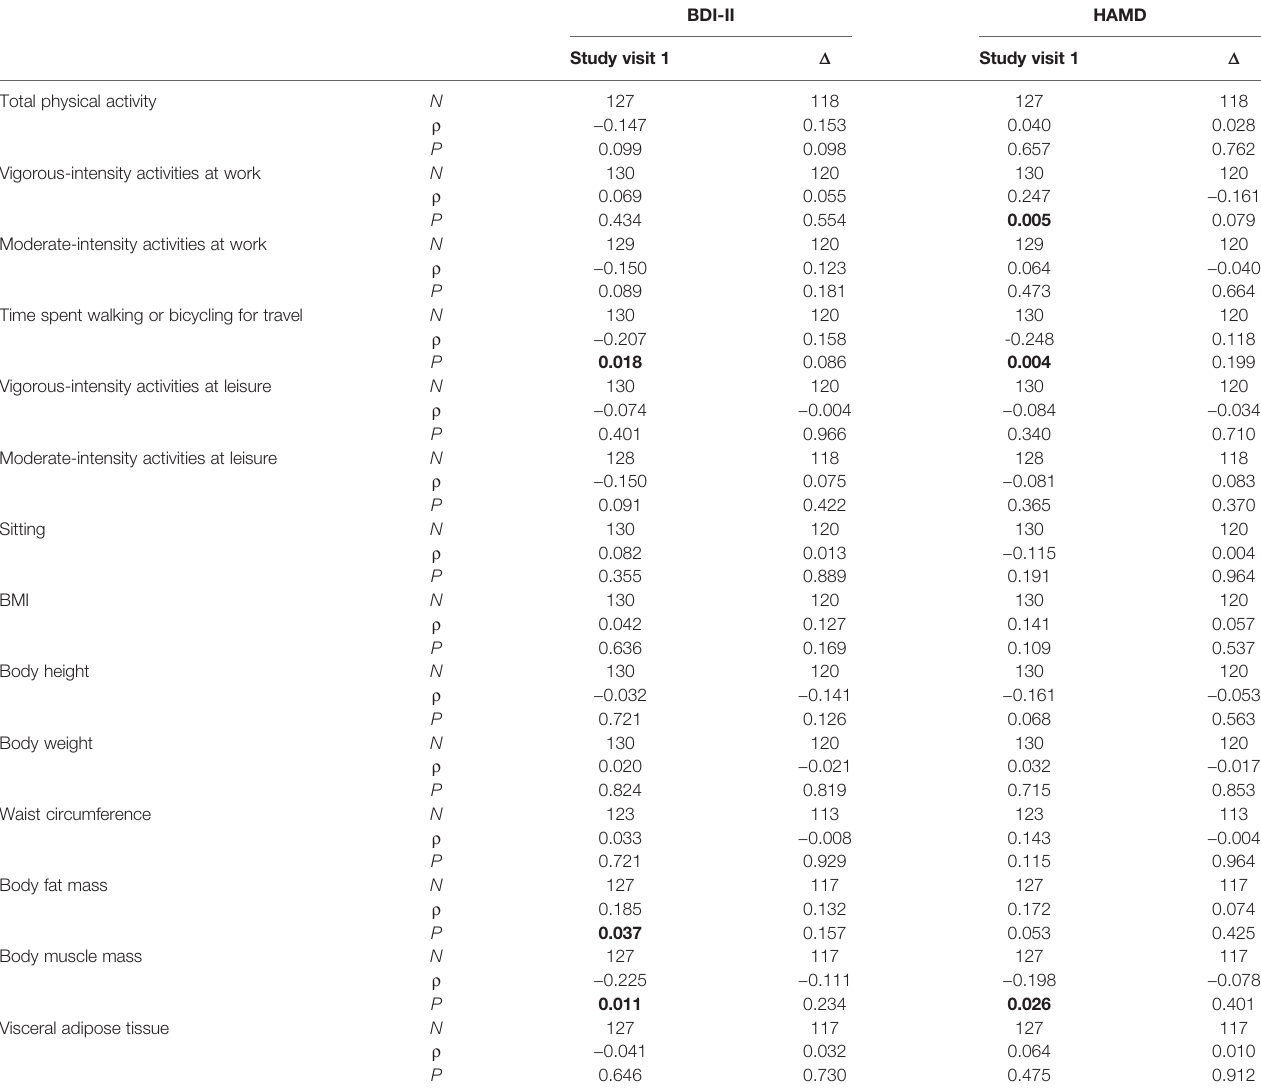
TABLE 2 | Spearman correlations between physical activity, body measures, and depression severity in patients with a current